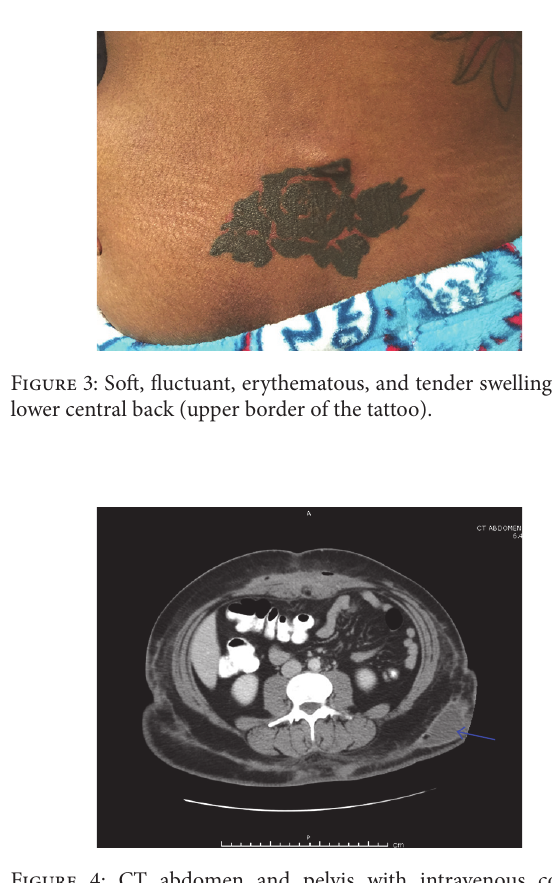
Figure 4: CT abdomen and pelvis with intravenous contrast showing subcutaneous rim-enhancing lesion in the left flank (blue arrow) suggestive of an